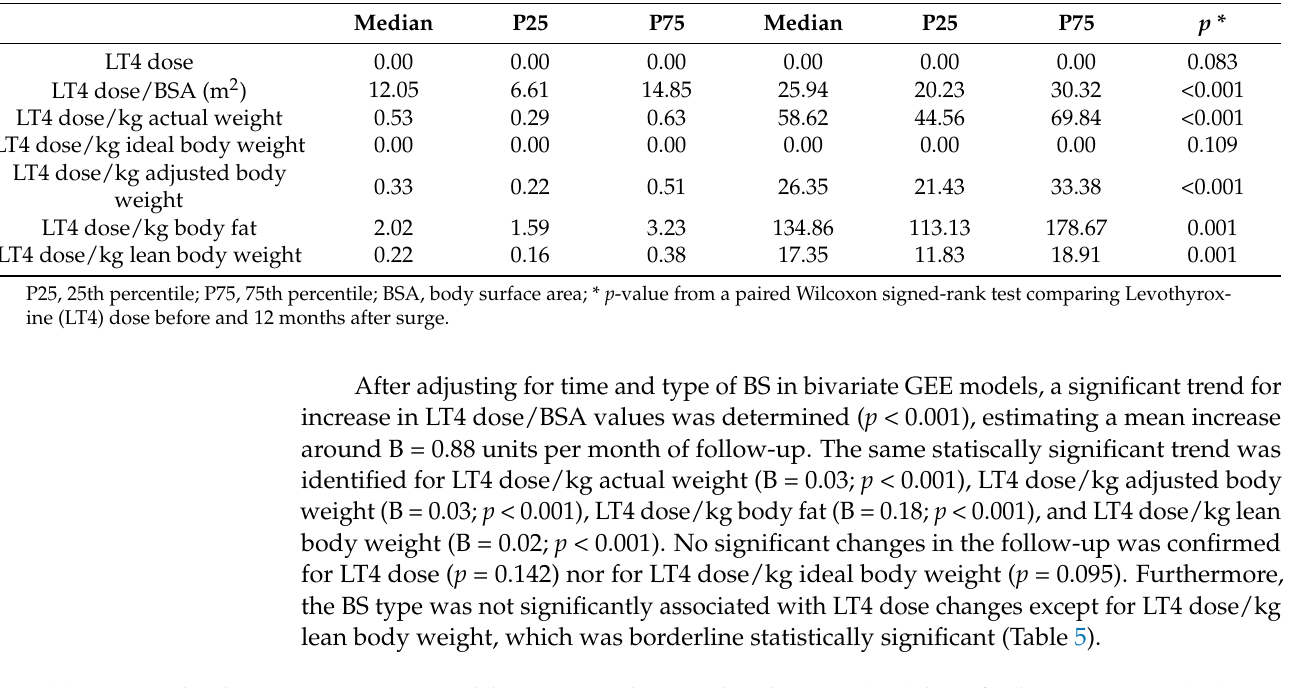
Table 5. Generalized estimating equation models examining change in levothyroxine (LT4) dose after bariatric surgery (BS), adjusting for BS type, sleeve gastrectomy (SG), or Roux-en-Y gastric bypass